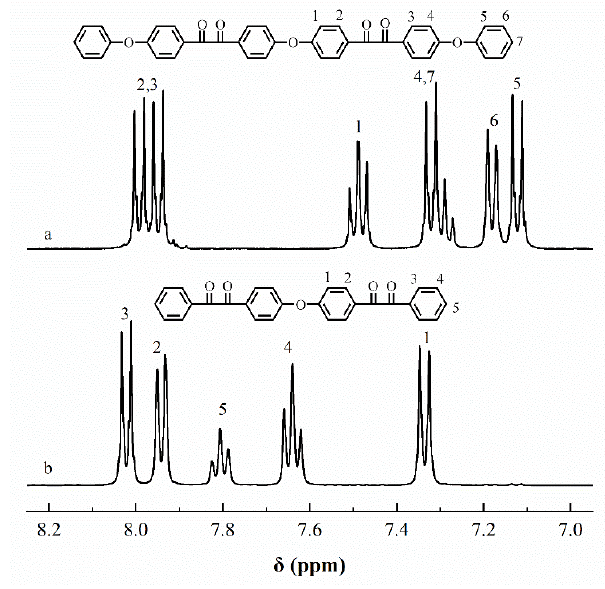
Figure 3. 1 H-NMR spectra of ODBZOBP ( a ) and ODBZ ( b ).